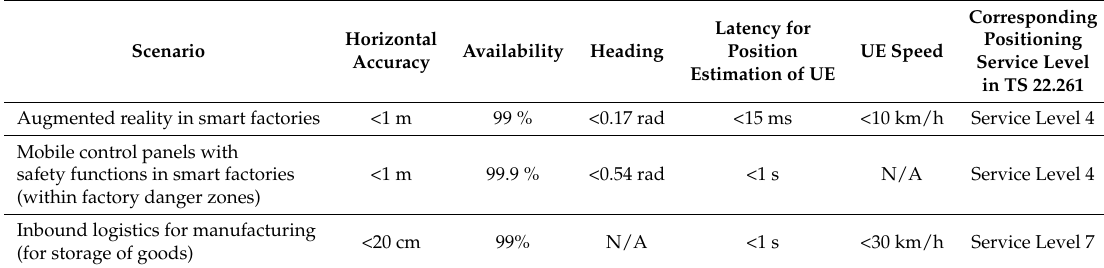
Table 3. A selection of positioning performance requirements for industrial use cases with reference